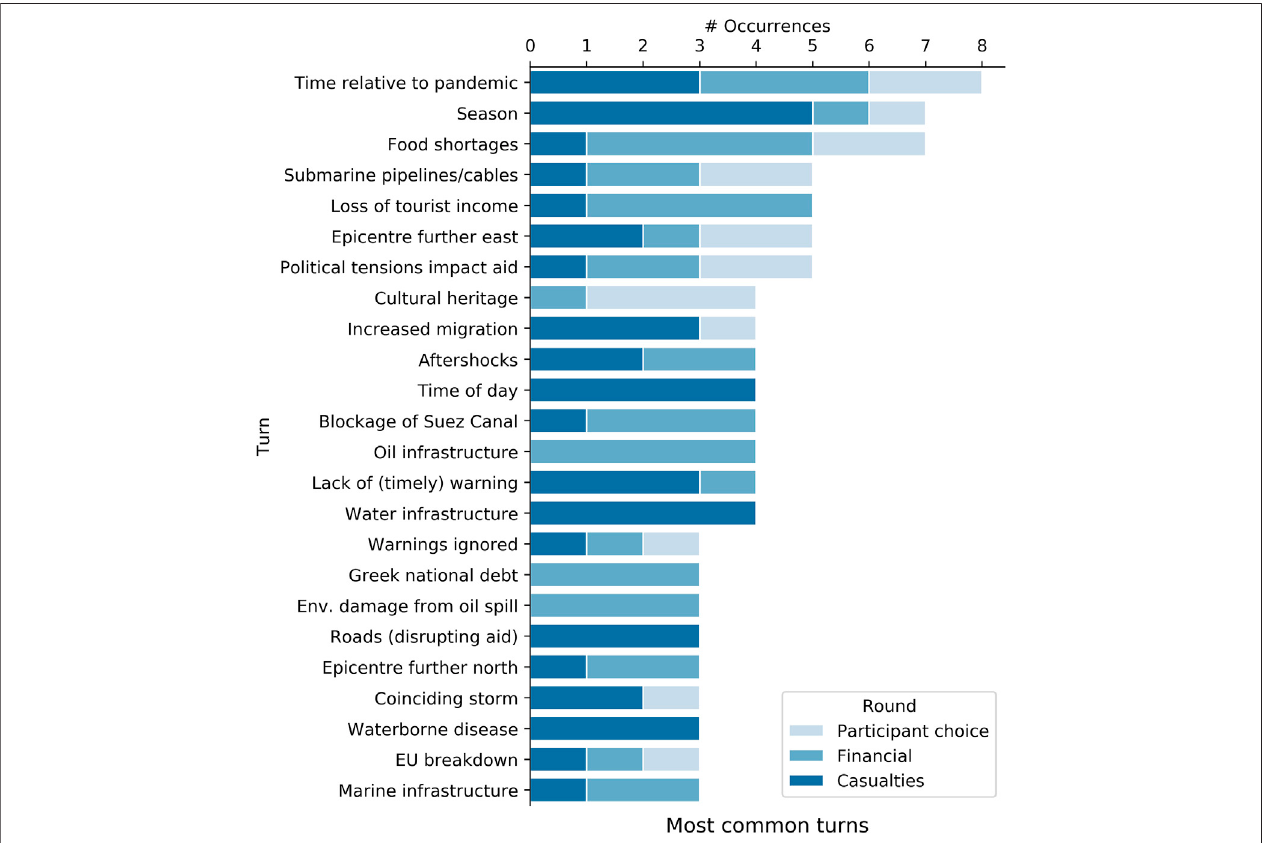
FIGURE 6 | Number of occurrences of common turns. Colours in the bars show the number of times a particular turn occurred in each round (note that each turn type can only occur once per round per convenor so the maximum number of occurrences would be 15 and fi ve occurrences in any round implies all groups used a particularturn).Turnswrittenasatypeofinfrastructurearegenerallyaboutdamagetothatinfrastructure. “ increaseinmigration ” referstoincreasednumbersofdisplaced people resulting from changes in economic or socio-political conditions, mostly with reference to current refugee camps near sea level on Greek islands (e.g., Chtouris and Miller,